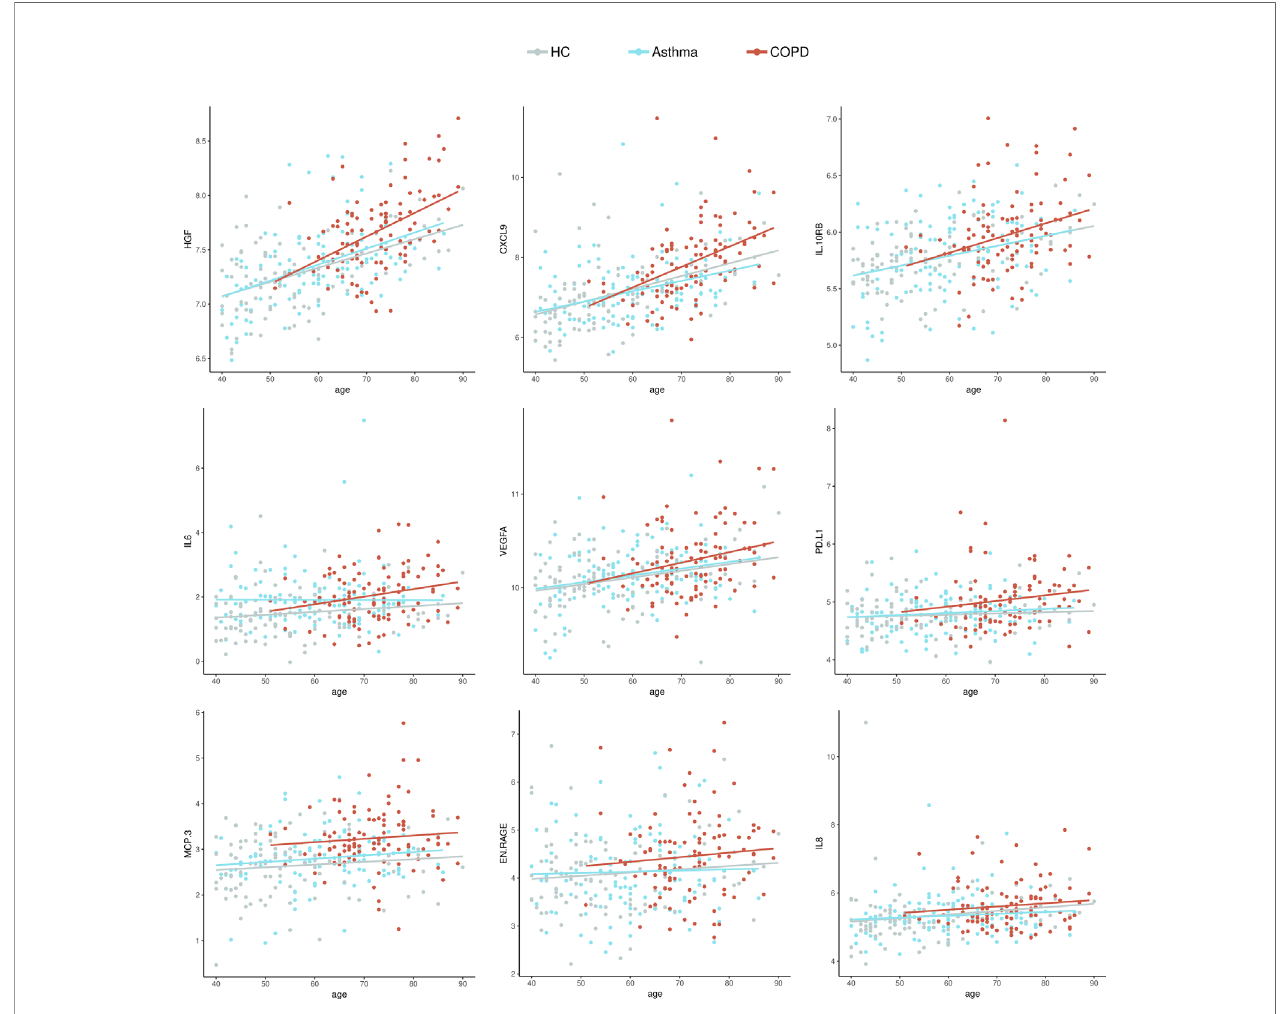
FIGURE 8 | Dot plots with the normalized protein levels (log 2 scale) in relation to age, each dot represent a subject. Lines represent the